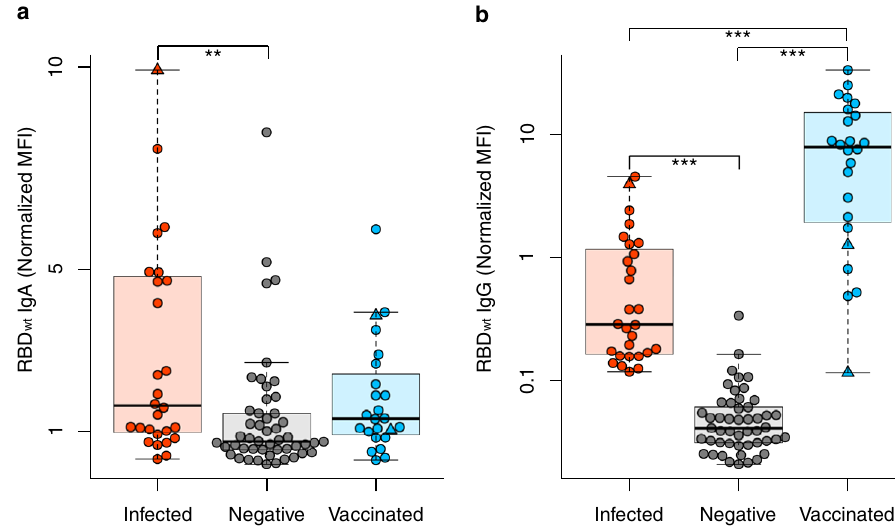
Fig. 2 IgA and IgG response in saliva samples of vaccinated, infected, and negative individuals. Box and whisker plots for the IgA ( a ) and IgG ( b ) response in the saliva of vaccinated (blue, n = 22), infected (red, n = 26), and negative (gray, n = 45) individuals. All samples were measured three times using MULTICOV-AB, normalized against QC values to remove confounding effects, and the mean calculated and displayed. Panel b is presented using a logarithmic scale for clarity. As additional controls, one infected and then vaccinated sample and two vaccinated samples from individuals not in contact with active COVID-19 infections are displayed as triangles. Boxes represent the median, 25th and 75th percentiles, whiskers show the largest and smallest non-outlier values. Outliers were determined by 1.5 times IQR. Statistical signi fi cance was calculated by Mann – Whitney U (two-sided) with signi fi cance determined as being < 0.01. **< 0.001; ***< 0.0001. Source data are provided as a Source Data fi